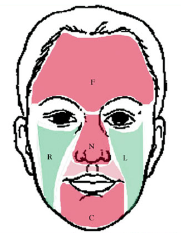
Figure 6. Facial region